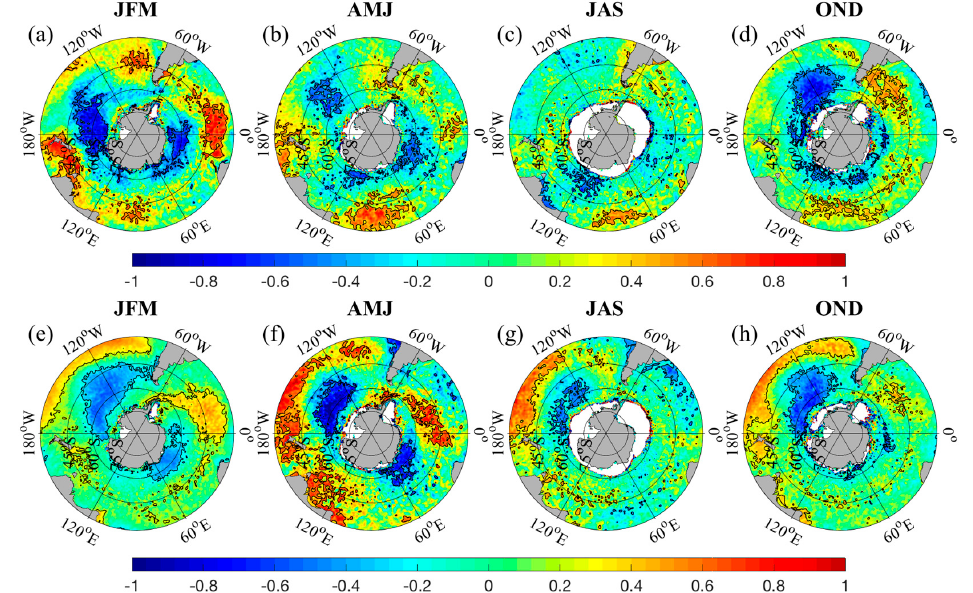
Figure 5. Coefficients of regression between the Southern Oscillation (AAO) ( a – d ) and standardized sea surface temperature (SST) anomalies (°C) from 1982 to 2016. ( a ) is monthly anomalies averaged over January to March (austral summer), ( b ) April through June, ( c ) July through September (austral winter), and ( d ) October to December. The coefficients of regression between the SO ( e – h ) SST anomalies are through the same temporal scale as ( a – d ) respectively. The largest coefficients occur with AAO and SO during the austral summer and autumn, while the smallest coefficients occur in austral winter.